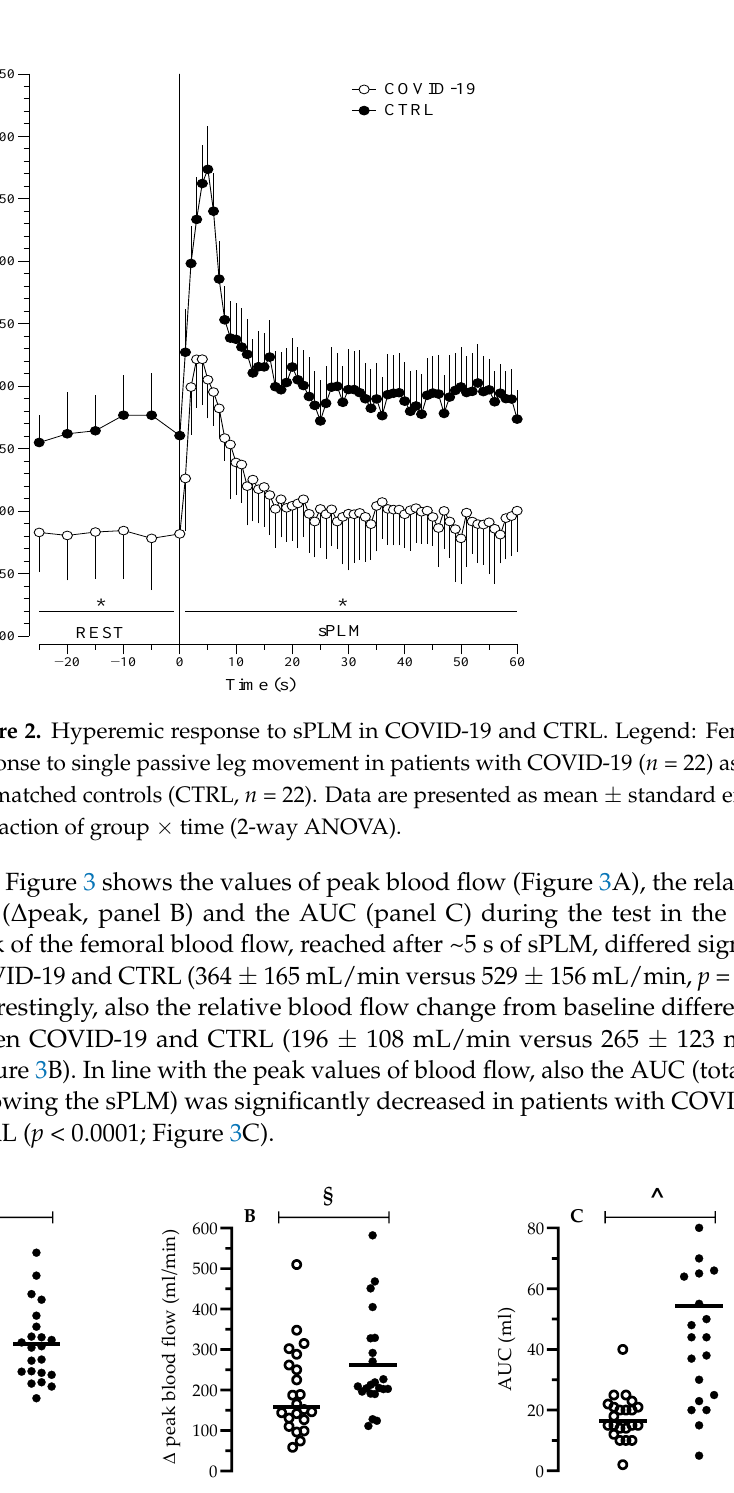
Figure 1. Femoral artery diameter ( A ), blood velocity ( B ) and femoral blood flow ( C ), at rest in COVID-19 patients ( n = Figure 1 22) versus age- and sex-matched controls (CTRL, n = 22). Data are presented in a scatter plot, and black bars indicate the mean value; * refers to p = 0.001, ^ refers to p < 0.001.